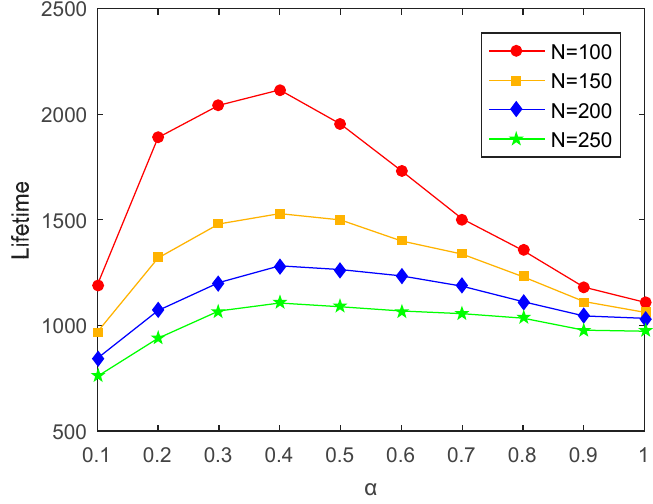
α on network lifetime (P = 0.3 W). Figure 5. Impact of